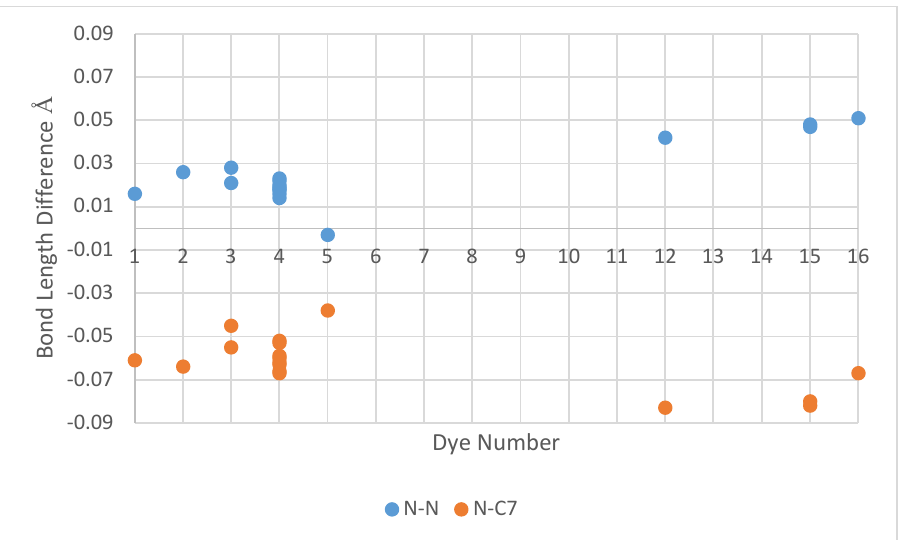
Figure 13. Difference in N-N and N-C7 bond lengths (Free Acid – Na Salt) for dyes where the free acid form is protonated on the azo N atom. There is no known Na salt crystal structure for similar dyes that have no entry. Dyes 1 to 5 have an OH substituent para to the azo group, dye 12 NMe 2 , and dyes 15 and 16 N(CH 2 CH 2 OH) 2 . Differences for 5 are relatively small as Na5 already has relatively short/long bonds due to its intramolecular hydrogen bond and resulting tautomeric forms. This intramolecular interaction does not occur in the free acid form H5 . Errors on differences are ±0.007 Å for 16 , ±0.005 Å for 3 and 12 and ±0.004 Å for all others.